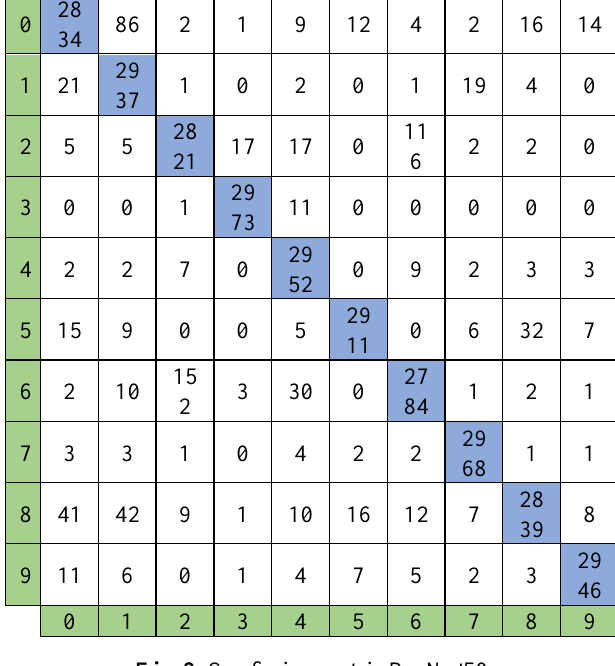
Fig. 8. Confusion matrix ResNet50